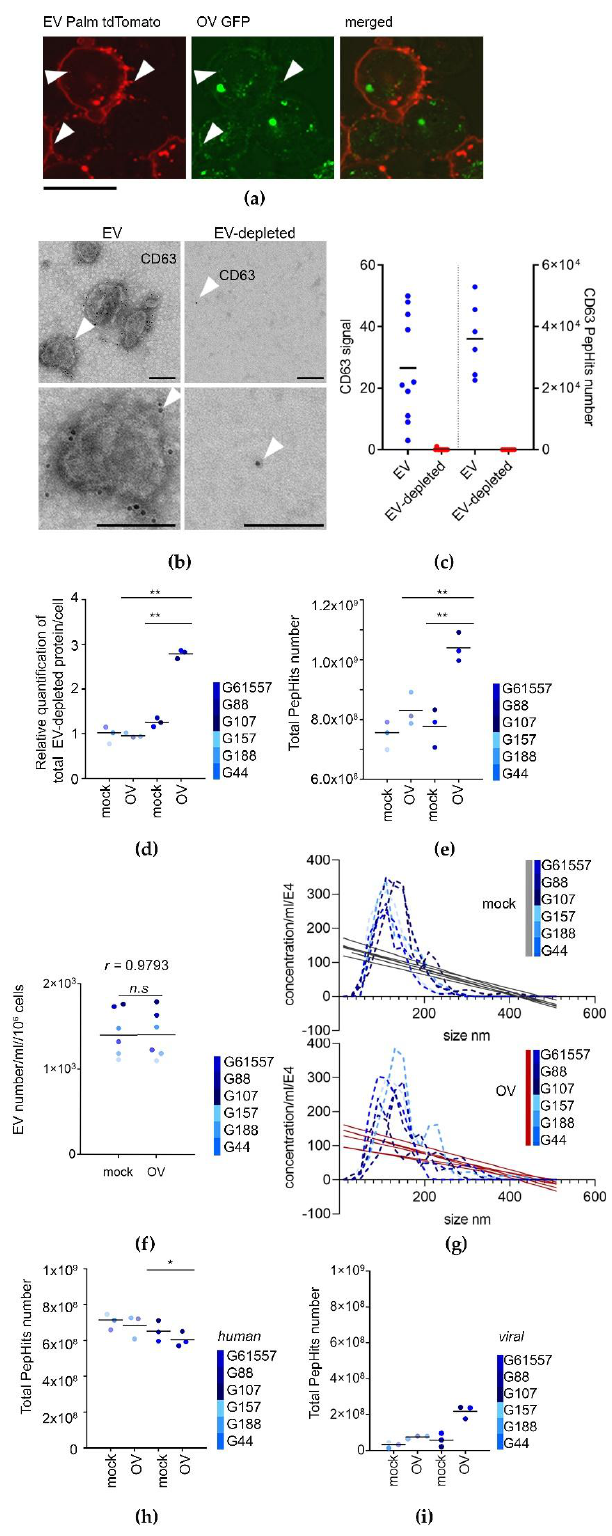
Figure 2. OV infection leads to quantitative and qualitative changes in both the extracellular vesicles (EV)-depleted and EV secretome of GSCs. ( a ) OV co-localizes with EVs within GSCs and upon secretion. Representative micrographs of cells 12 h after infection and colocalization of OV/EV by fluorescent confocal microscopy. Arrows point the co-localization signal; scale bar: 25 µ m; red